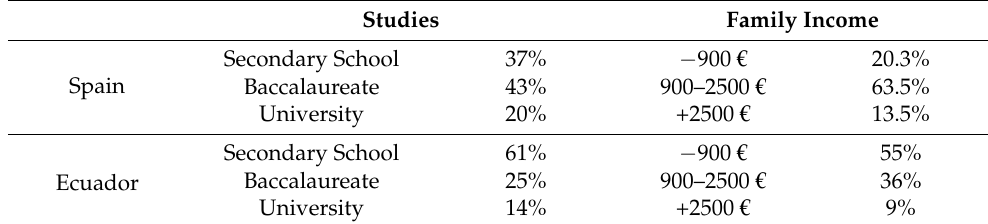
Table 1. Sociodemographic data of the sample.